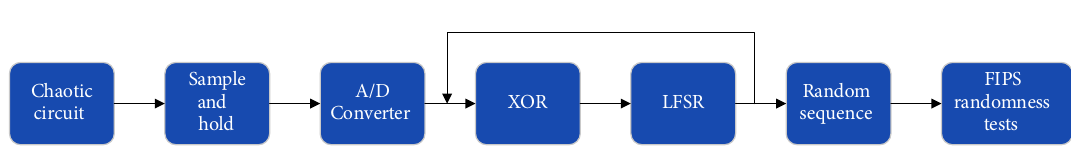
Figure 2: The typical TRNG structure.